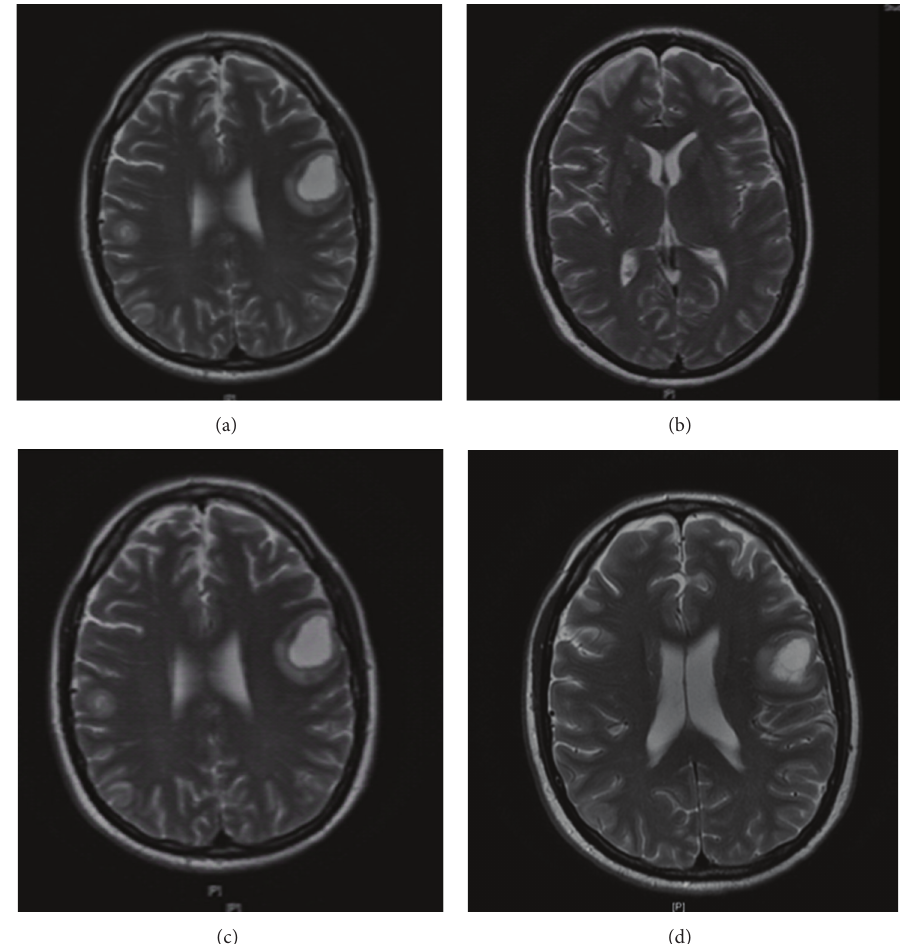
Figure 4: Magnetic resonance imaging of head showing multiple new acute hemorrhages in gray-white junction, mainly seen in the intra- and supratentorial space, measuring 2 cm or